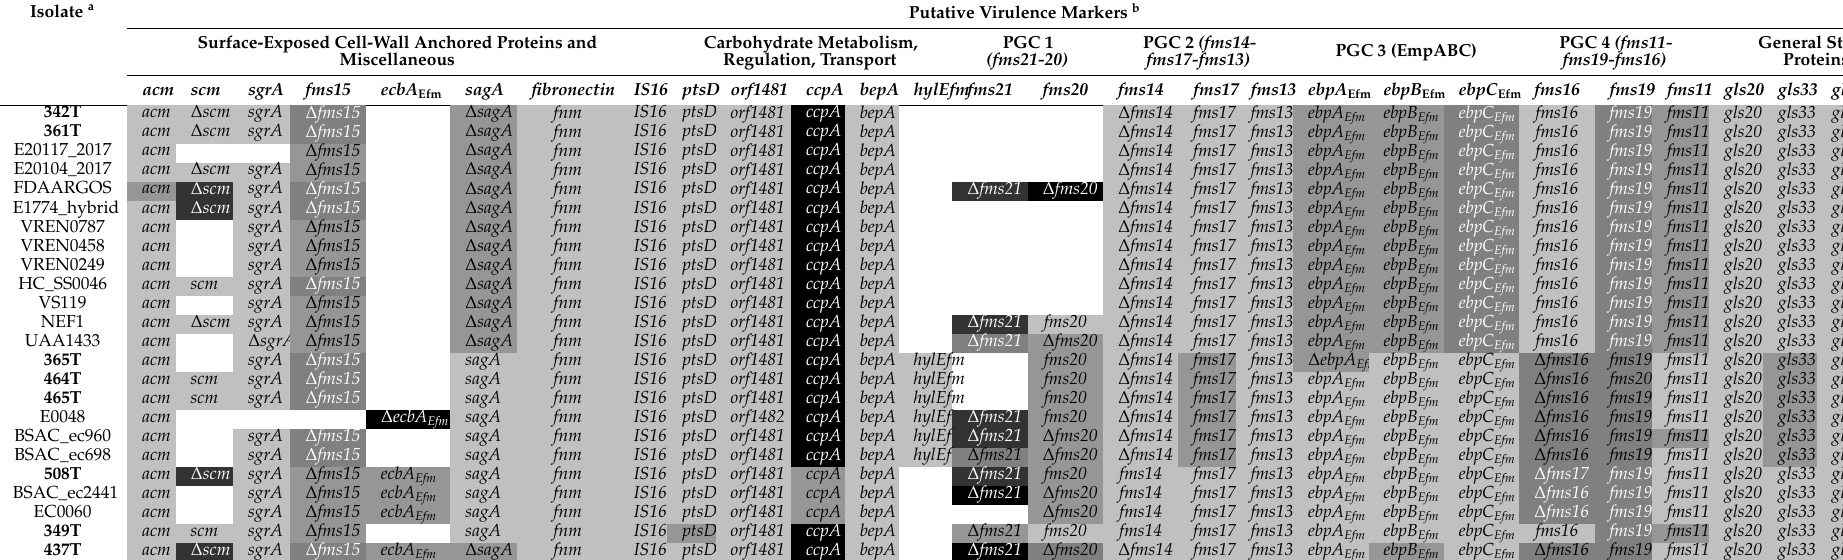
Abbreviations: PGC, pili gene cluster; fms , E. faecium surface protein. a Isolates are ordered and separated according with their clustering in the phylogenetic tree (Figure 1). Isolates in bold correspond to those sequenced in this study. b The virulence genes are presented in different grey tones according to the highest homology they present with strain reference ( E. faecium TX16) retrieved in MyDBFinder and obtained from our in-house database. Truncated forms are represented with ∆